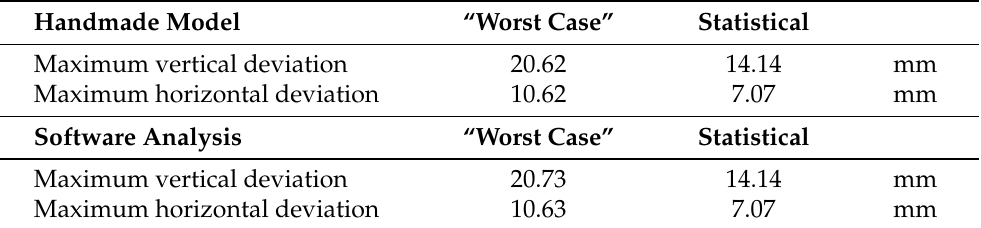
Figure 9. Comparison of the displacements of relevant nodes between different angular positions of the gantry, where each component is measured in the rotating reference system along the x axis: ( a ) axial displacement. ( b ) Radial displacement. ( c ) Out-of-plane non-rigid displacement. See Figure 5 for nodes-average and rigid displacements. Table 1. Results of the evaluation of vertical and horizontal deviations between the main sup- ports due to the stack-up problem. The results are shown for both the handmade model and the software